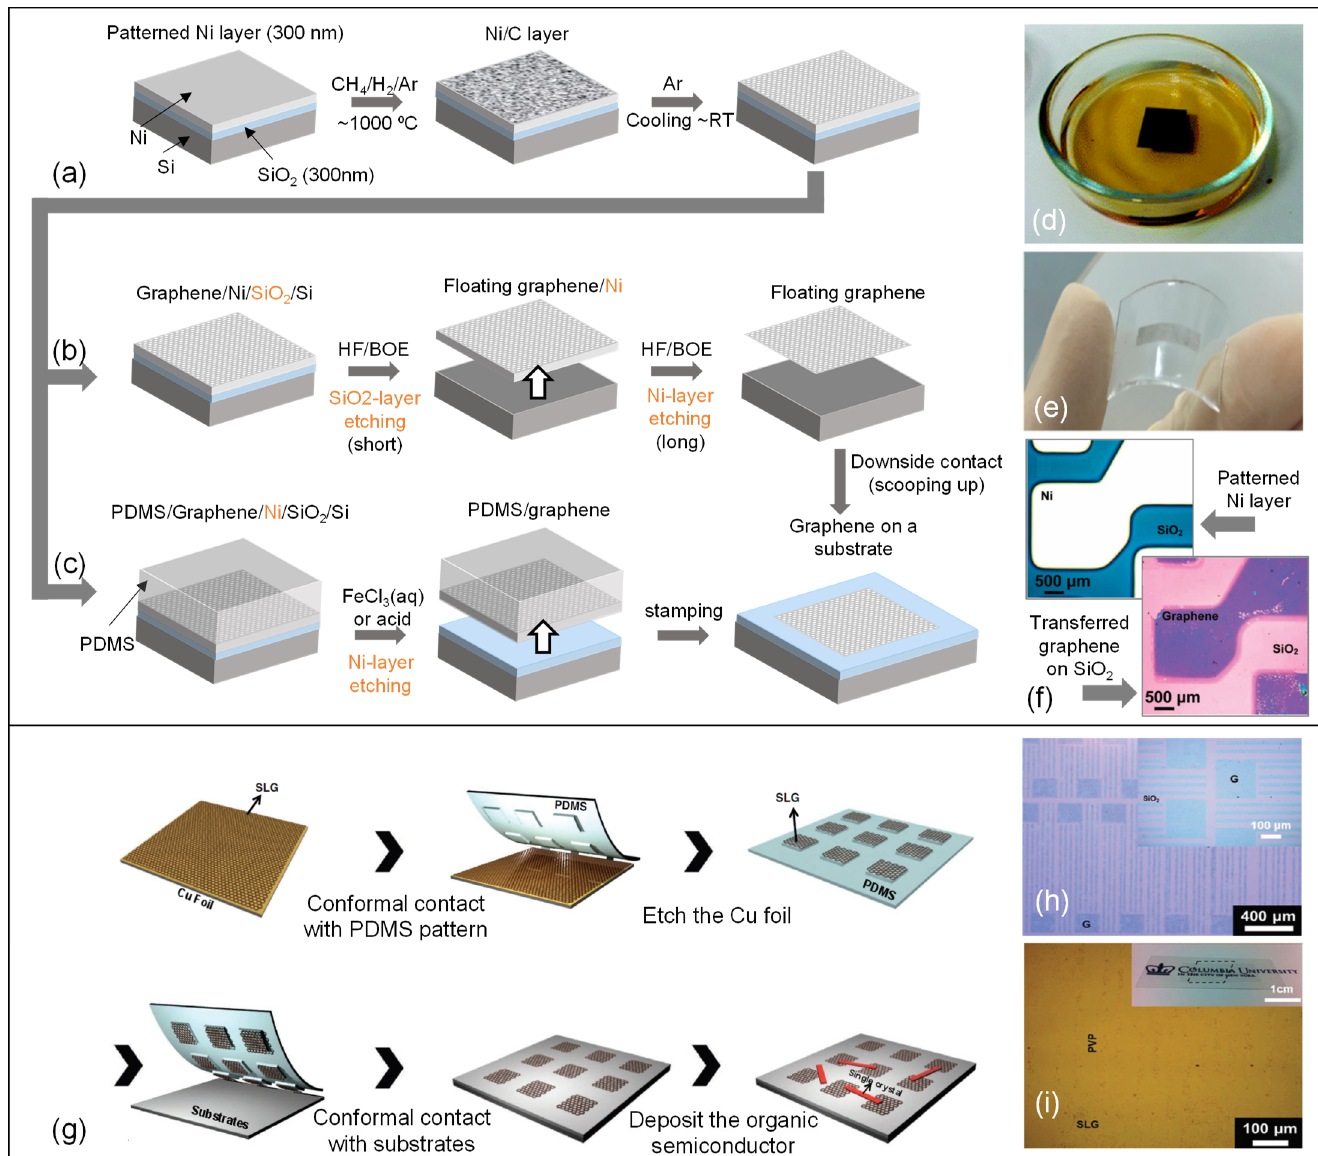
Figure 4. Dry transfer process for a graphene film grown on a Ni film using a soft substrate, PDMS. ( a – c ) Schematic illustration of synthesis, etching and transferring processes of graphene films without and with a PDMS stamp. Reprinted with permission from ref. [101]. Copyright (2009) Springer Nature. ( d ) Using FeCl 3 solution to etch underlying Ni layer. Reprinted with permission from ref. [137]. Copyright (2009) Royal Society of Chemistry.( e ) Transparent graphene films on the PDMS substrate. Reprinted with permission from ref. [138]. Copyright (2017) Elsevier ( f ) Optical microscope image of a patterned nickel layer on which graphene is grown and image of the graphene layer on a SiO 2 substrate following successful transfer. Adapted with permission from ref. [133]. Copyright (2009) American Chemical Society. ( g ) A schematic of micropatterned single layer graphene